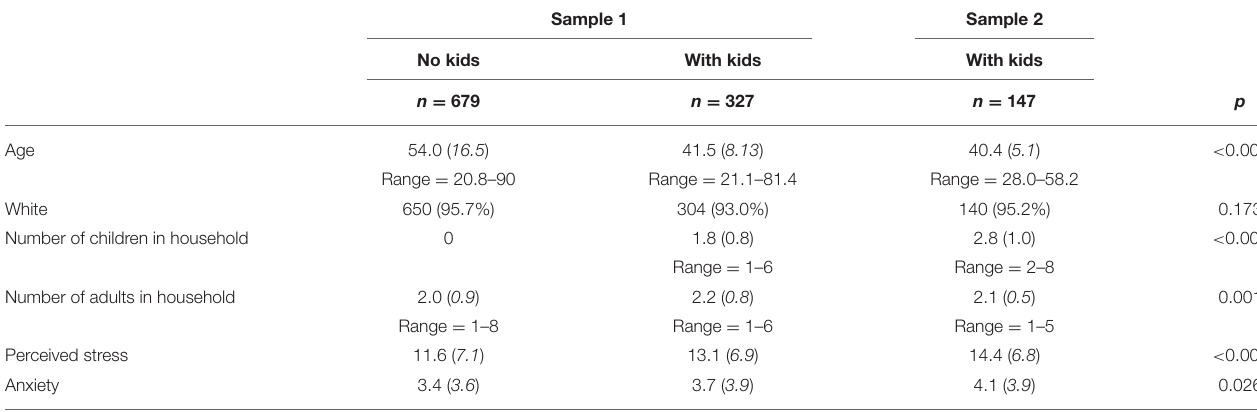
TABLE 1 | Descriptive statistics of select demographic characteristics, number of children and adults in household, perceived stress, and anxiety in two samples of women.